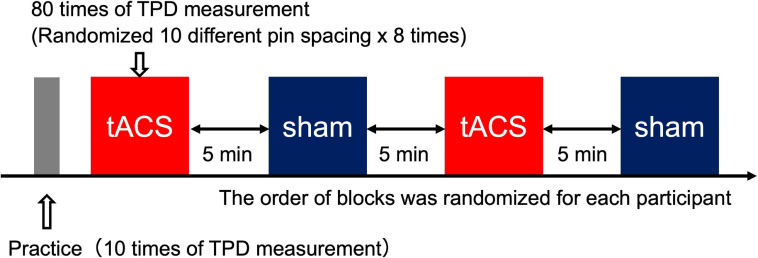
Experimental procedure. Each block included 80 trials (five trials × 18 intervals). There were four blocks in total (two blocks for the tACS condition and two blocks for the sham condition). The order of the blocks was randomized for each participant to minimize order effects. In total, 160 trials (80 trials × two blocks) from each condition were used for subsequent analysis.